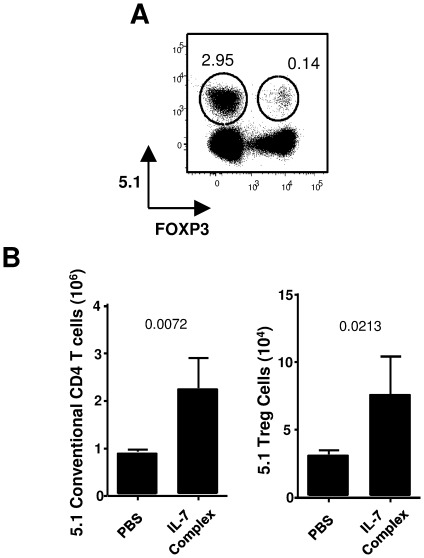
IL-7 induced expansion of both conventional and regulatory T cells is thymic independent.CFSE labeled total CD4 T cells from CD45.1 mice were transferred into CD45.2 C57Bl/6 hosts. Mice were then treated with IL-7/anti-IL-7 complexes as in Fig. 2. (A) Representative dot plots of CD45.1 vs FOXP3 expression on CD4+ TCRβ cells recovered from lymph nodes and spleens of PBS or IL-7 complexes treated mice. (B) Total numbers of adoptively transferred CD45.1 FOXP3− conventional T cells (left panels) and CD45.1 FOXP3+ regulatory T cells (right panels) from lymph nodes and spleen.